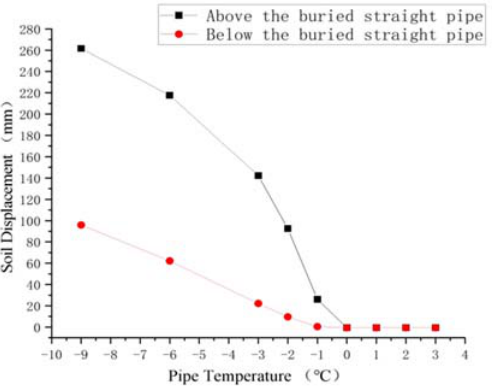
Figure 19. Frost heave displacement diagram of soil near the buried ascending pipe with pipe temperature variation.